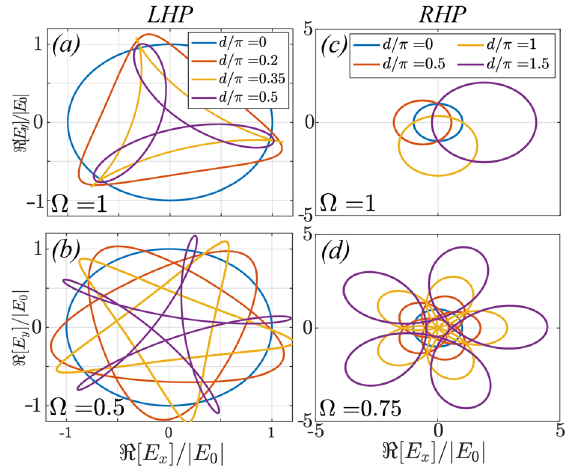
Fig. 7 The x and y components of the transmitted electric fi eld form a Lissajous fi gure, which originates from the beating between the frequency of the input wave ω = 1 and that of the screw Ω . The commensurabilityratiobetweenthetwodeterminesthenumberoflobesinthe fi gure.ForRHPinput( a - b )thescrewisabletoamplifythewavesastheypropagate throughathickness d .Bycontrast,aLHPinputwave( c - d )isnotampli fi ed,but